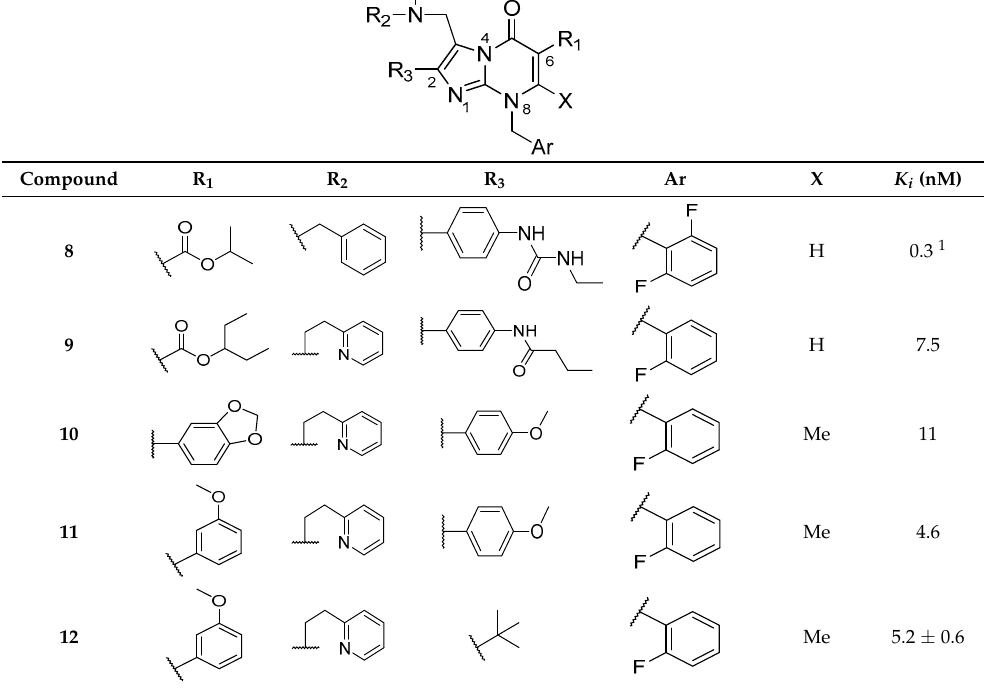
Compound Compound Compound